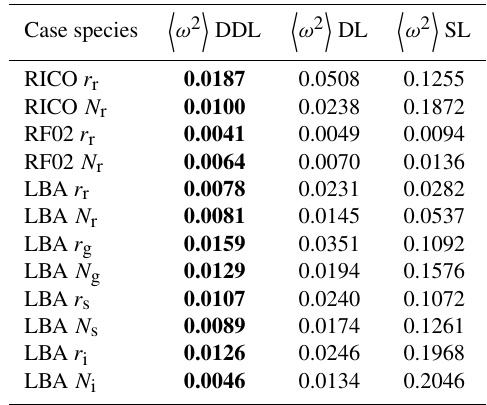
Table 2. Normalized Cramer–von Mises statistic averaged over multiple grid levels and statistical output timesteps comparing each of DDL, DL, and SL hydrometeor PDF shapes to SAM LES re- sults. The best (lowest) average score for each case and hydrome- teor species is listed in bold. The DDL has the lowest average score every time, and the DL has the second-lowest average score every